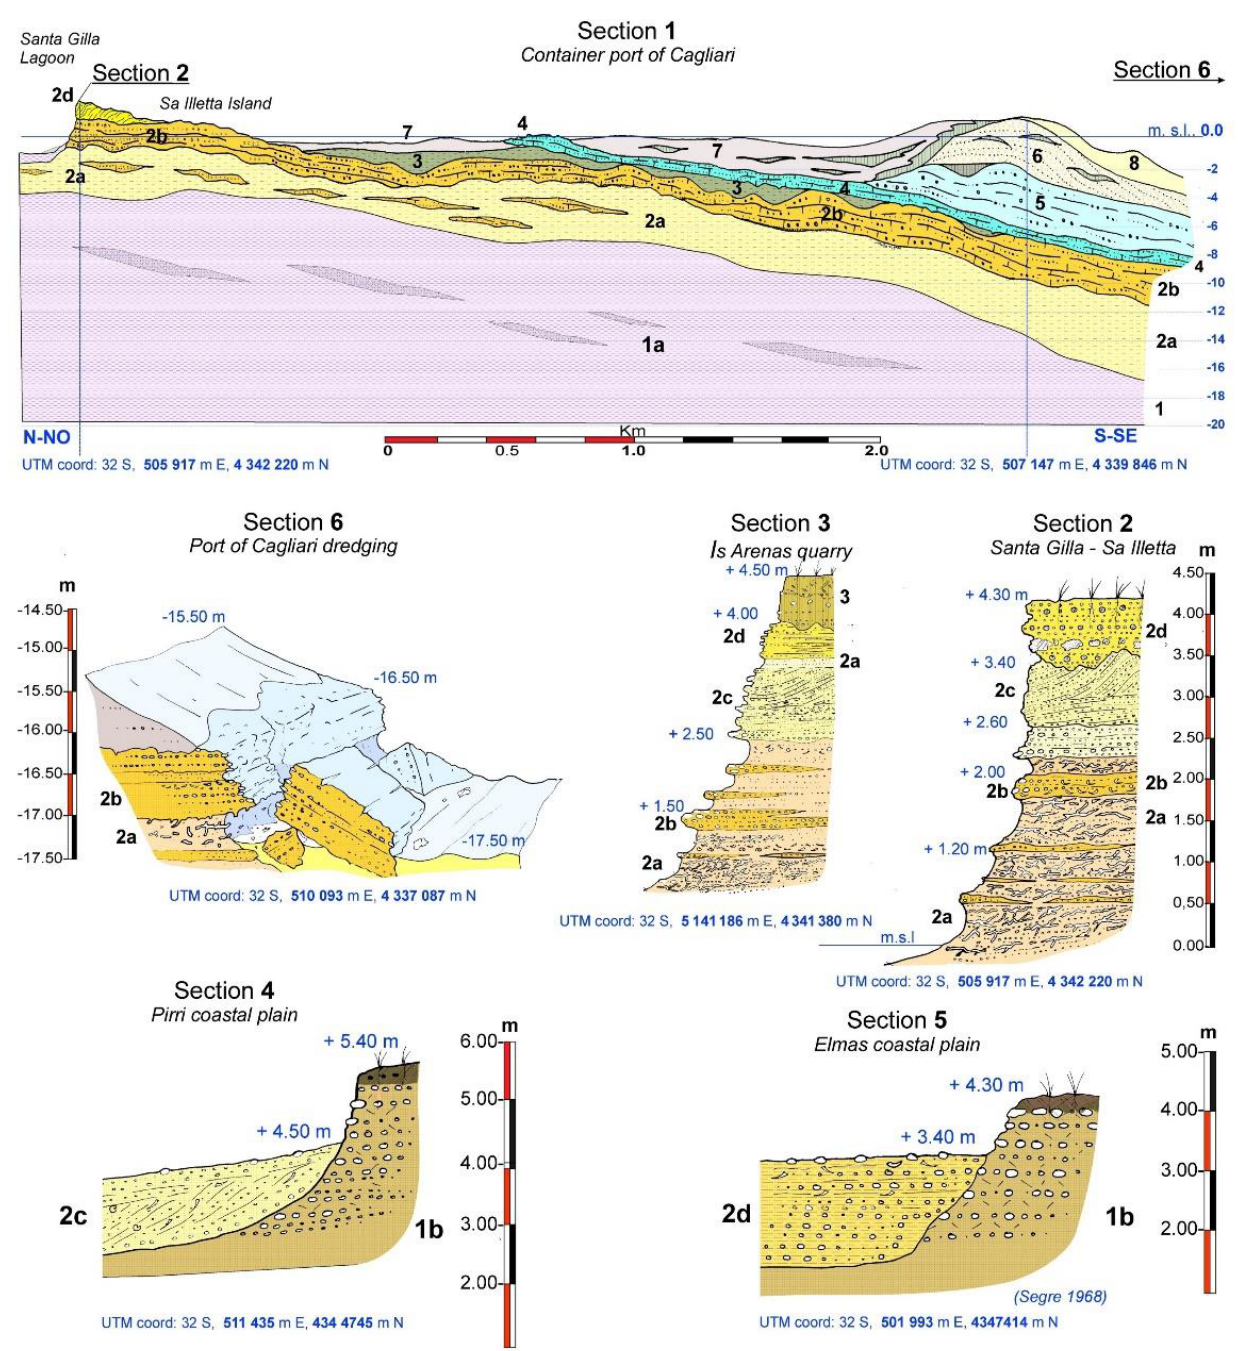
Figure 4. Stratigraphic sections of the MIS 5.5 sequences in the Cagliari coastal plain. (1a) (Section 1): deltaic complex in silt and sandy silt with clay and sand with Ostrea sp. in lenses (MIS 6); (1b) (Sections 4/5): fluvial deposit with polygenic and heterometric pebbles in oxidized clayey silt matrix, weakly cemented (MIS 6); (2a): mainly sandy littoral deposit irregularly cemented with burrows bioturbation structures, containing Persistisstrombus latus e Cerastoderma glaucum (MIS 5); (2b): mainly quartz conglomerates and microconglomerates fossiliferous with plane-parallel lamination (MIS5); (2c): polygenic gravels and sands alternating with fossiliferous horizons, to inclined lamination and foresets (MIS 5); (2d): bioclastic sandstone in Lithtaminium and bioconstructions in Cladocora coespitosa ; (3a): limi sabbiosi palustri (MIS 4/2); (3b): silty sands with pulmonate gastropods (MIS 4/2); (4): bioclastic sandstone in Cerastoderna sp (Holocene); (5): polygenic gravel with sandy matrix (Holocene); (6): littoral sands and gravels (Holocene); (7): silty sands lagoon deposits with interbedded peat in Posidonia oceanica (present); (8): sandy littoral deposits